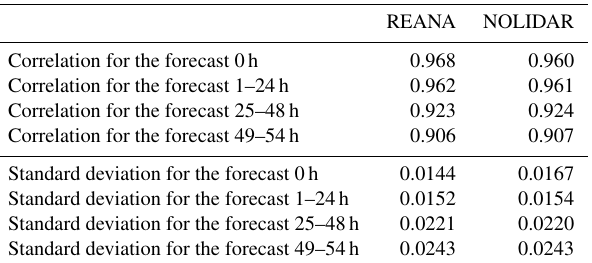
Figure 9. Equitable threat score of the 24h accumulated precipita- tion from the 6–30h forecast range of the long forecast initialized at 00:00UTC each day of the period from 5 September to 5 Novem- ber 2012 computed over the AROME-WMED domain with rain gauges of the HyMeX database (version 4). Dots indicate that the difference between the curves is statistically significant. Table 6. Correlations and standard deviations of zenithal total de- lays (in m) between AROME-WMED forecasts from 00:00UTC and reprocessed GNSS observations averaged over forecast ranges (0, 1–24, 25–48 and 49–54h).